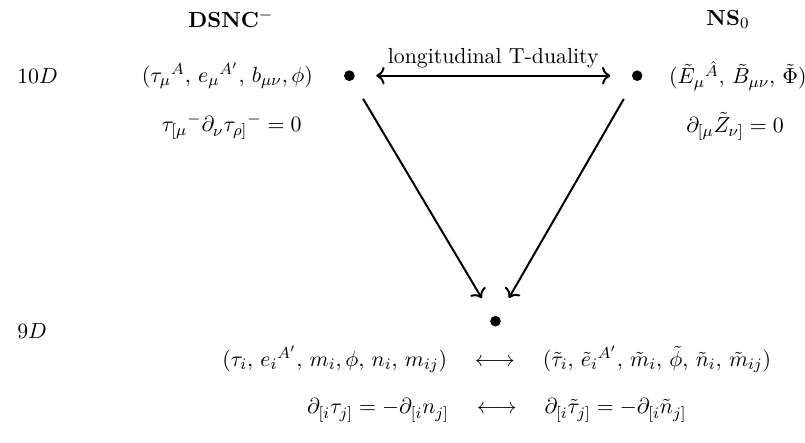
Figure 2 . Schematic overview of the target space approach to longitudinal T-duality T L . The non-relativistic T-duality rules (2.18) are obtained by matching the nine-dimensional fields following from a null reduction of NS 0 gravity with those following from a longitudinal reduction of DSNC − gravity. Furthermore, we have indicated the respective geometric constraints: (1.1) in the DSNC − theory, (2.21) in the NS 0 theory, and the nine-dimensional versions